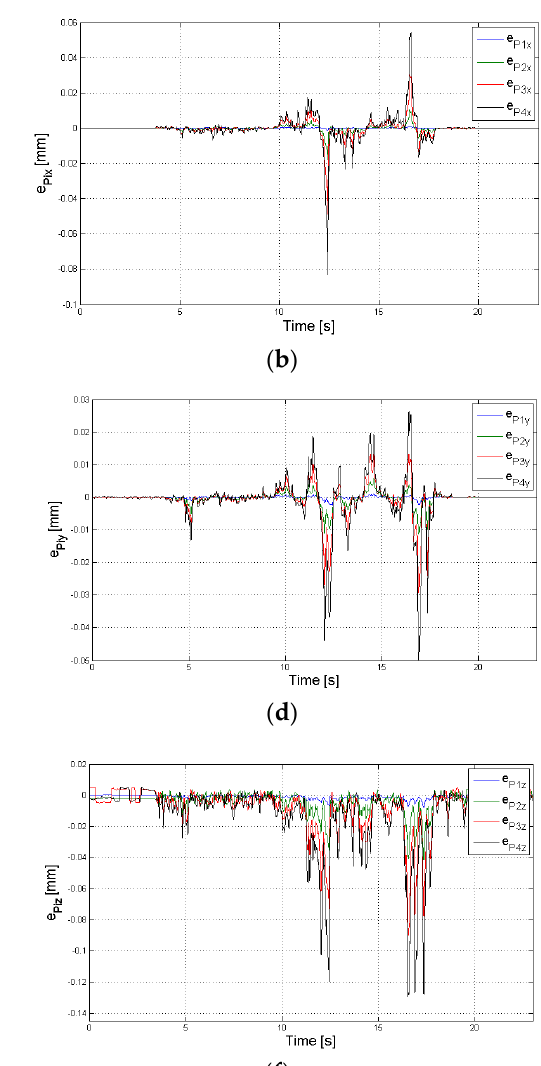
( b ) Figure 8. Variation of the relative angles between platforms ( a ) angle θ jx ( b ) angle θ jy .